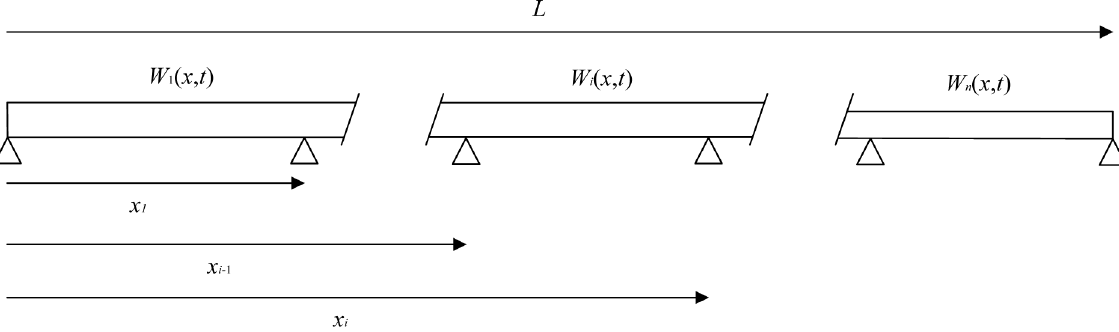
Fig. 1. Multi-span beam with simple intermediate